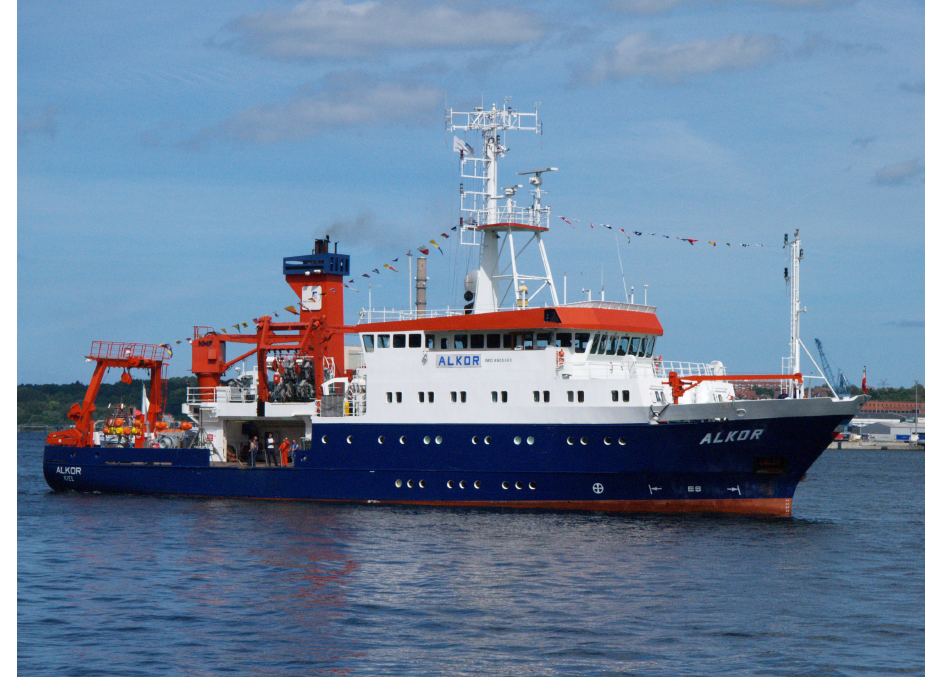
Figure 1: R/V ALKOR entering Kiel